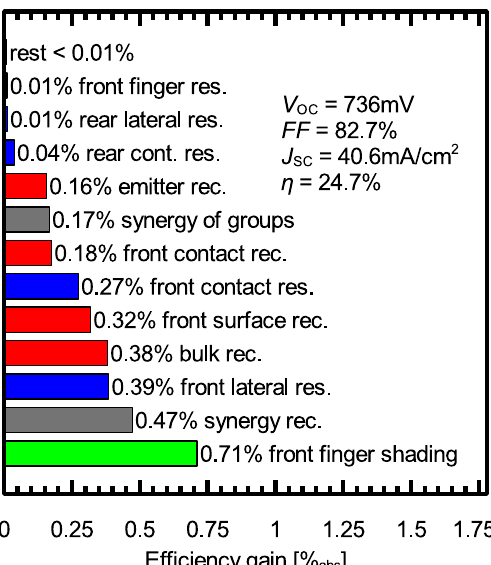
Figure 4. SEGA for the POLO BJ cell discussed in this study. Red bars show potential efficiency gains due to recombination, green bars gain due to optical losses and blue bars gain due to resistive losses. The gray bars show synergistic gains.